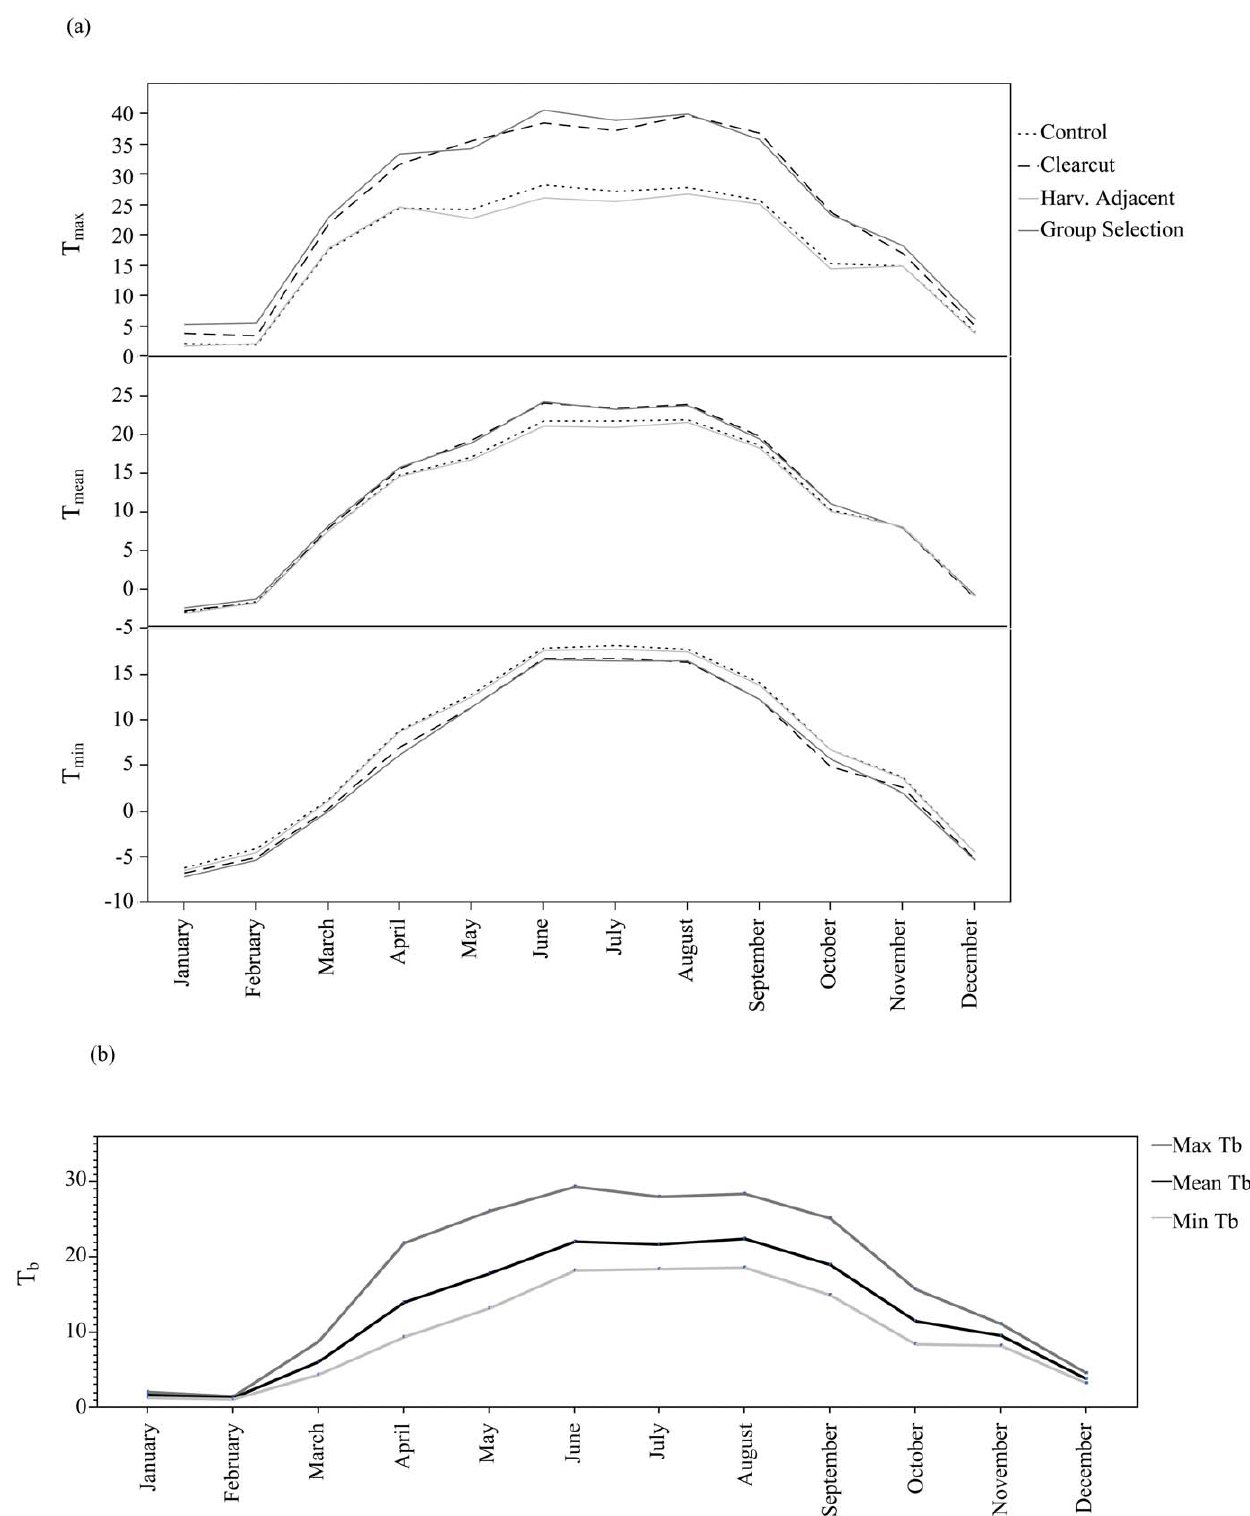
Figure 4. Habitat and Animal Temperature Ranges. Mean monthly temperature maxima (Tmax), mean (Tmean), and minima (Tmin) over two years (2009–2010) by habitat type (clearcut openings, group selection openings, harvest-adjacent forest (Harv. Adjacent), and forested control) (a). Maxima, means, and minima monthly eastern box turtle body temperatures (Tb) for the same period (b).